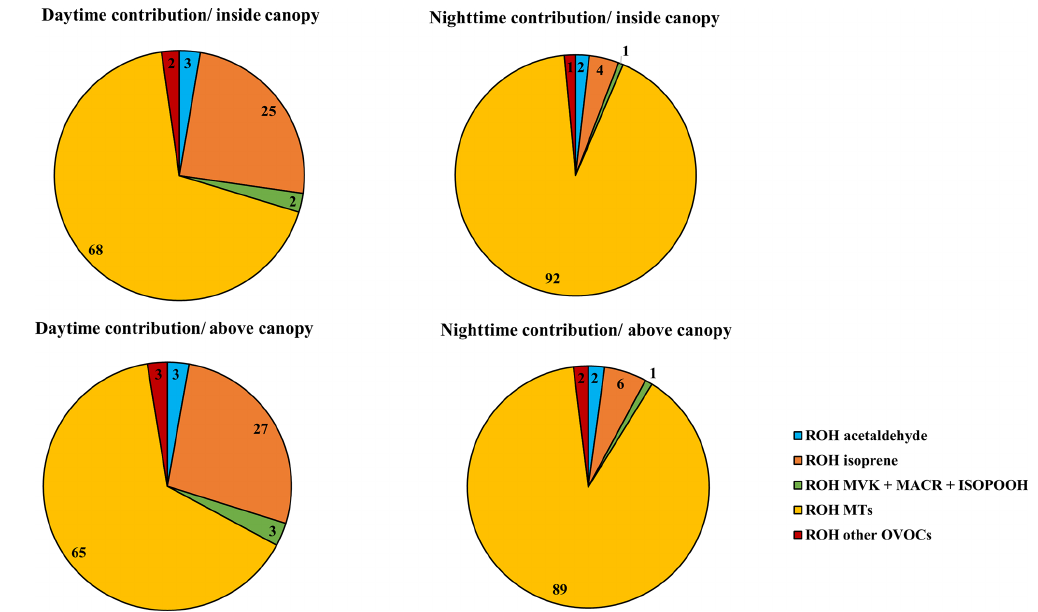
Figure 7. The components of calculated OH reactivity within and above the canopy during daytime and